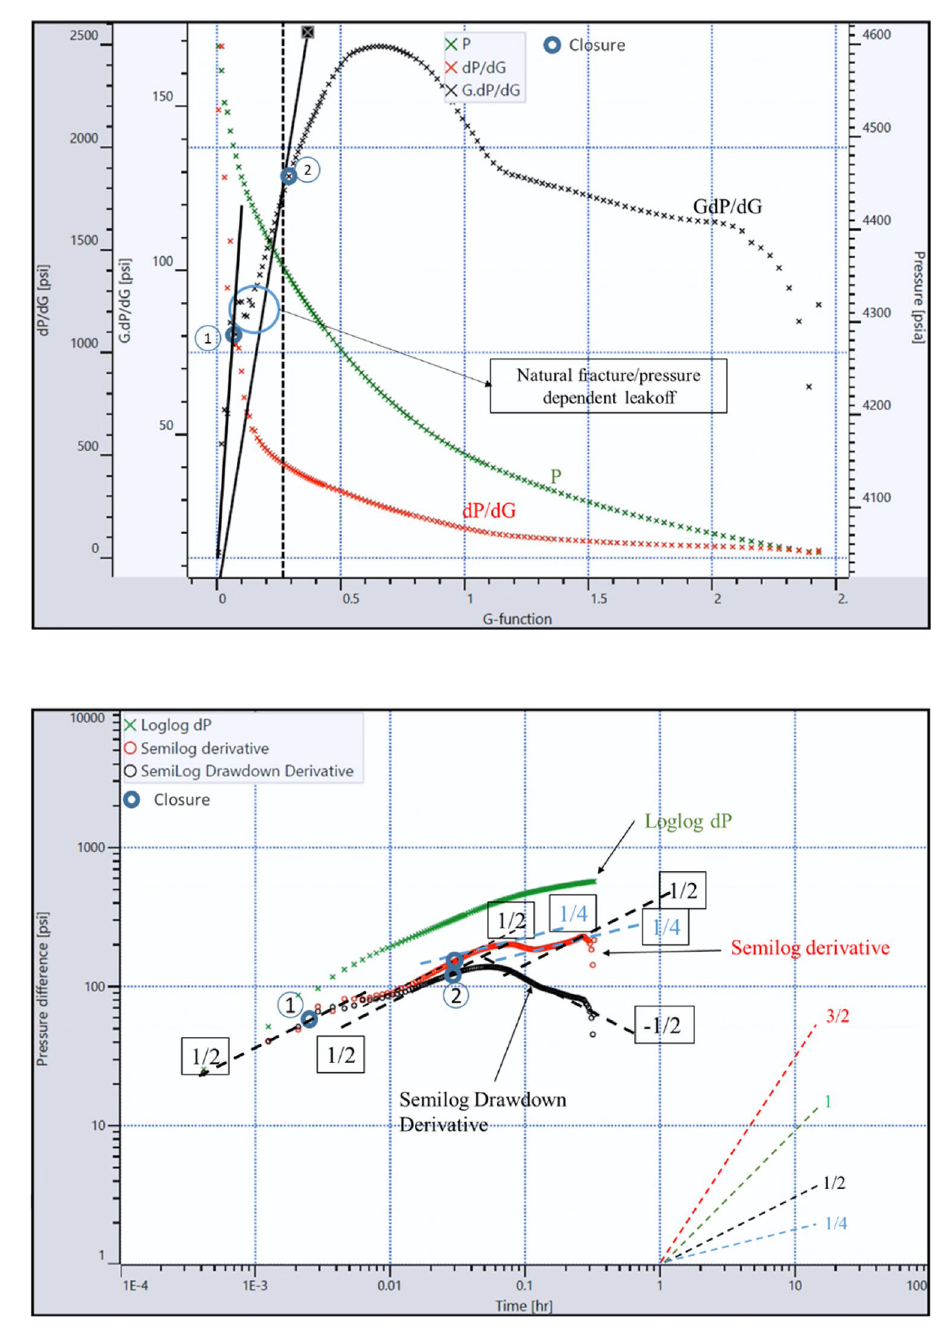
Fig. 14 A G-function plot for the DFIT test (Cycle #6). A couple of “humps” in the semilog derivative, as well as, upward concave in the primary P versus G exhibit PDL behavior